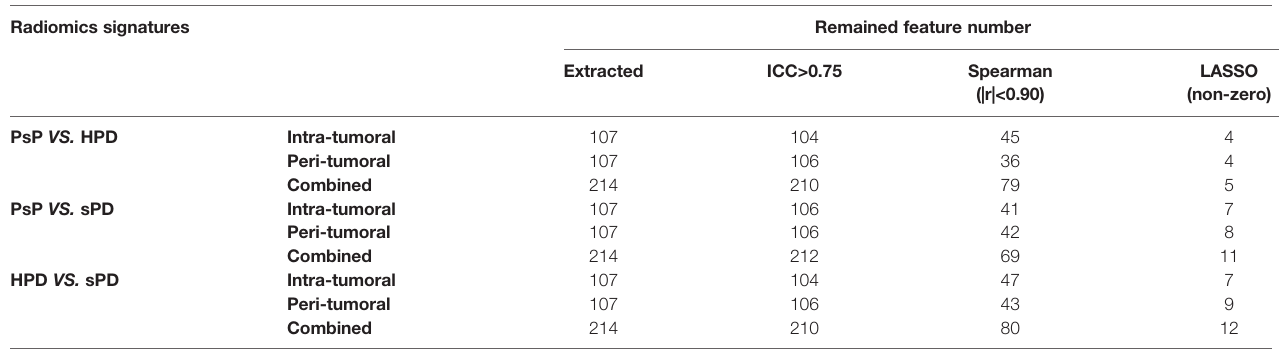
TABLE 2 | The process of features selection.